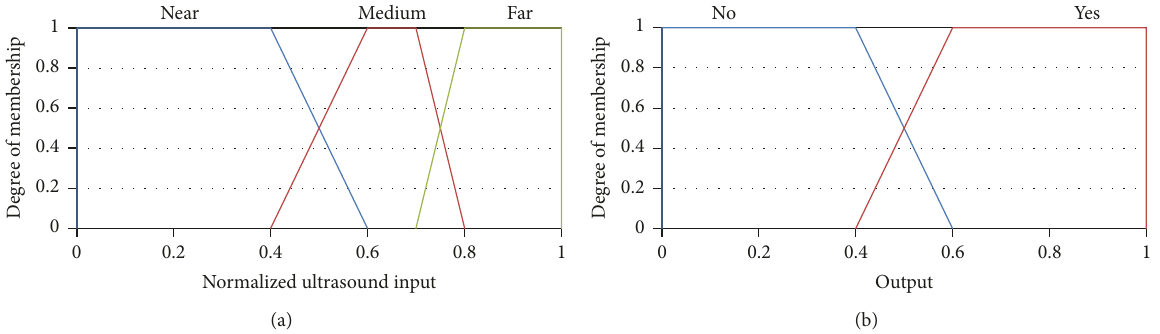
Figure 8: Labels for the ultrasound fuzzy controller: (a) input and (b) output.